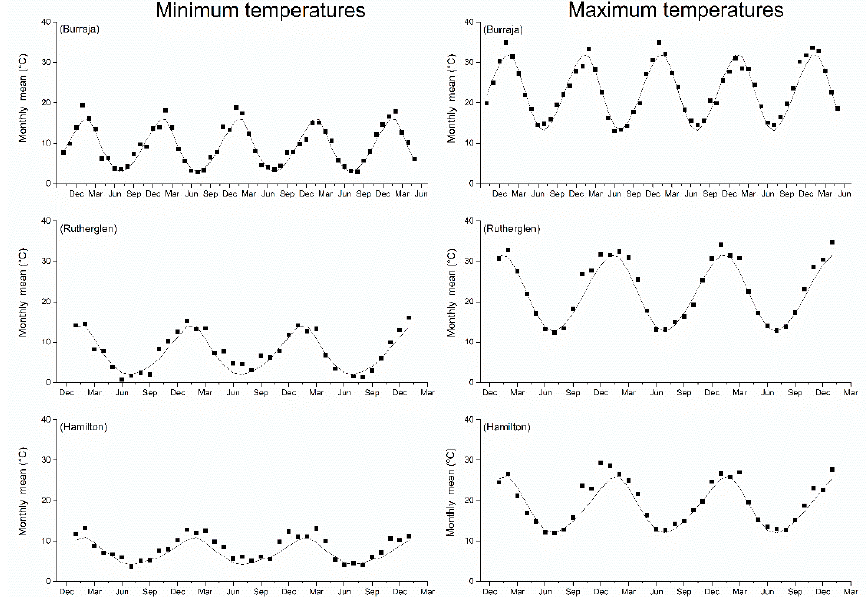
Figure 3. Mean minimum and maximum temperatures (°C, black squares) and long-term average at Burraja over 45 years (black line) (top); long-term average at Rutherglen over 50 years (middle); long term average at Hamilton over 50 years (bottom).